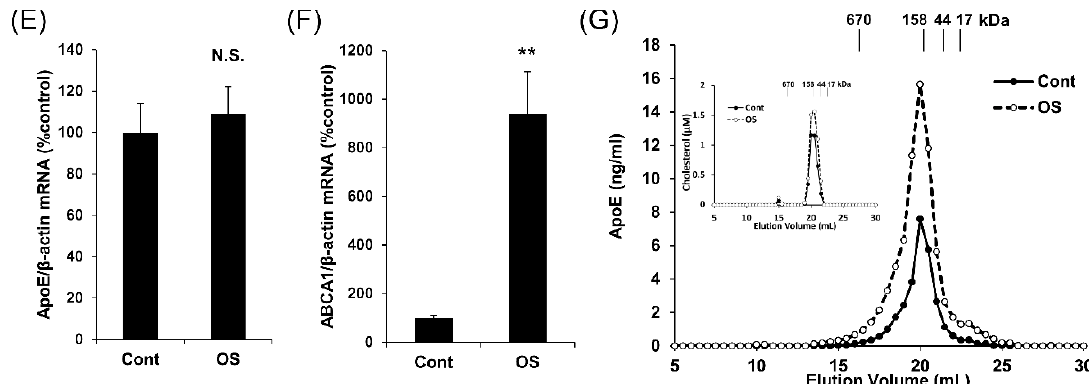
Figure 3. OS increases ABCA1 expression and high molecular size apoE secretion. Protein levels of ABCA1 ( A ) and ABCG1 ( B ) in immortalized astrocytes derived from apoE3-TR mice were analyzed by Western blotting after treatment with OS (1 µ M) for 24 h. The graph represents the quantification of ABCA1 and ABCG1 levels. ( C – E ) After treatment with OS (1 µ M) for 24 h, protein levels of LDLR ( C ) and LRP1 ( D ) were determined by ELISA, and mRNA levels of apoE ( E ) and ABCA1 ( F ) were measured by qRT-PCR and normalized by the mRNA levels of β -actin in immortalized astrocytes derived from apoE3-TR mice. ( G ) The culture media were concentrated and then fractioned by size-exclusion chromatography on fast protein liquid chromatography (FPLC) using tandem Superose-6 columns. The concentration of apoE and cholesterol (inset) in each fraction was analyzed by ELISA and enzymatic assay, respectively. ( A – F ) Data represent mean ± SE ( A – F : n = 3, biological replicate group). ** p < 0.01, NS; non-significant; Student t -test.